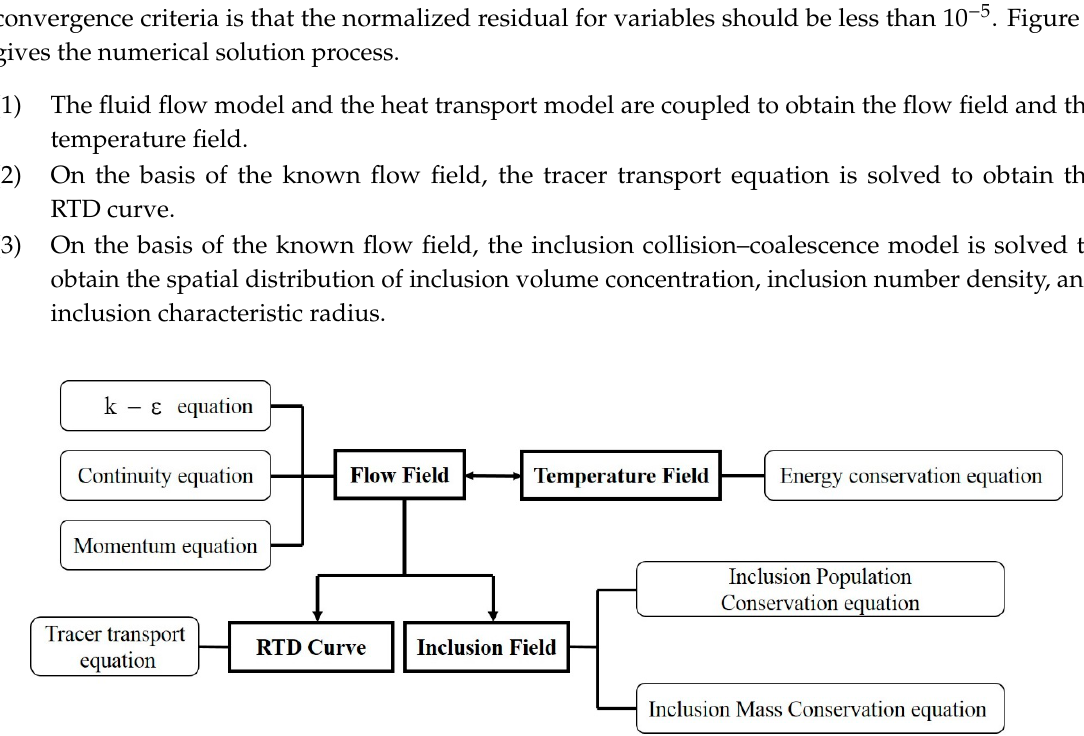
Table 4. Physical parameters and boundary conditions [28–30].